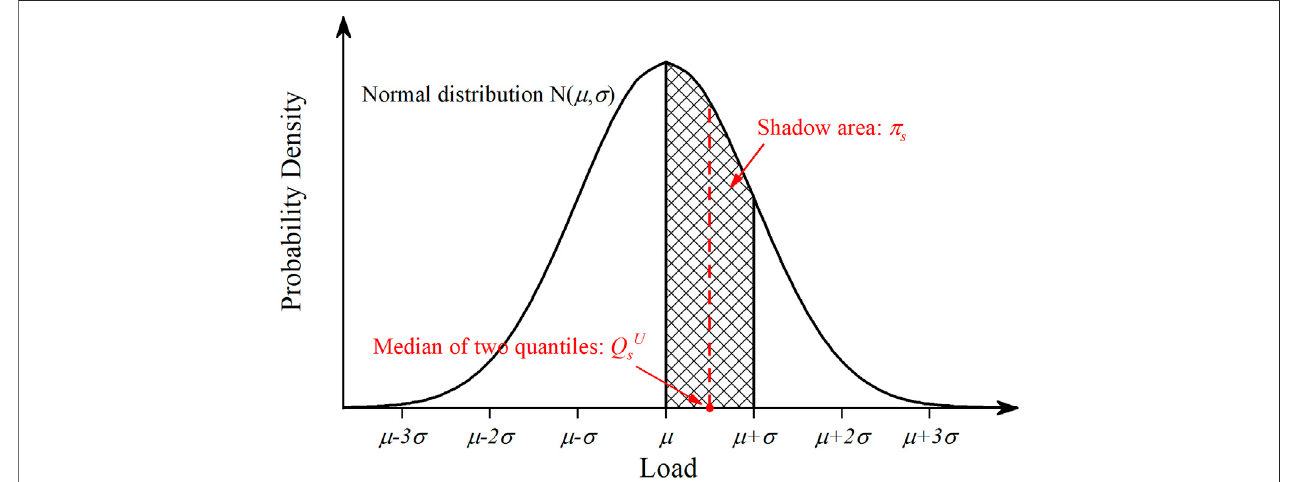
FIGURE 3 | The method of sample user load based on normal distribution quantile.